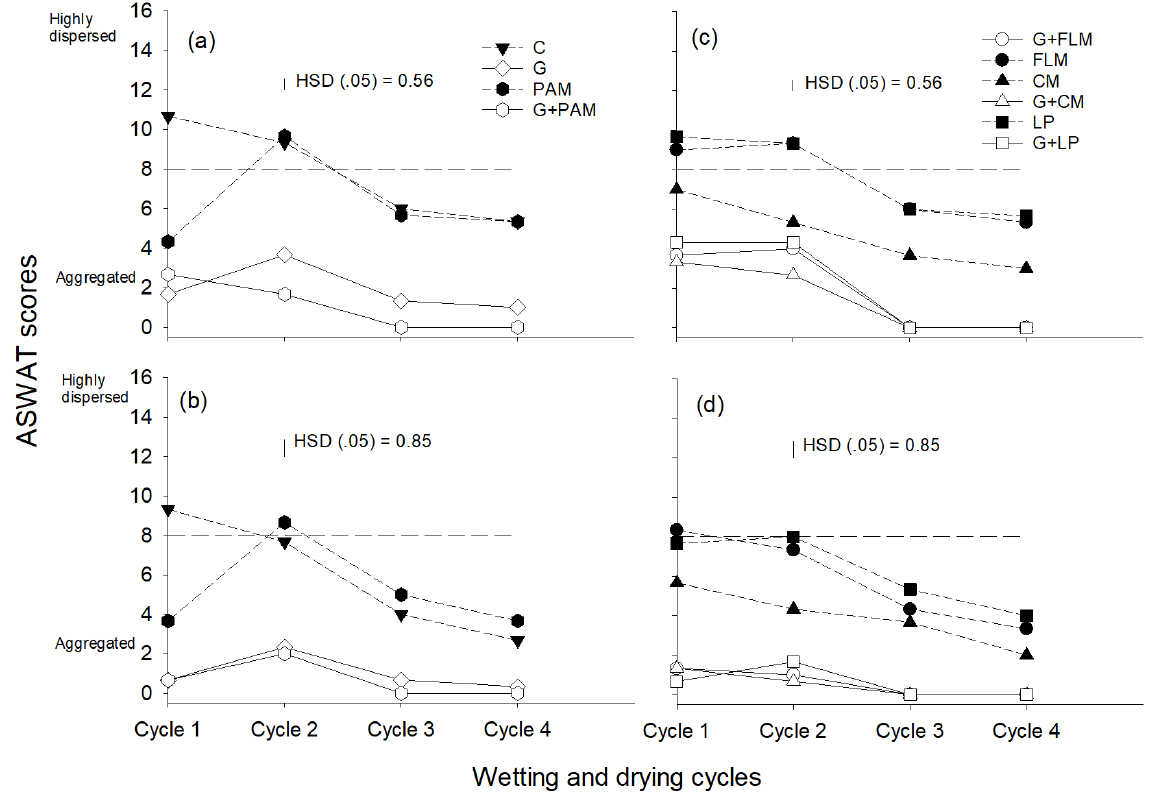
Figure 3. The ASWAT scores of soils after the addition of amendments during four wetting and drying (WD) cycles, Soil 1 (a, c) and Soil 2 (b, d) . The amendments are C: control, G: gypsum, PAM: anionic polyacrylamide, G + PAM: gypsum + anionic polyacrylamide, FLM: feedlot manure, G + FLM: gypsum + feedlot manure, CM: chicken manure, G + CM: gypsum + chicken manure, LP: lucerne pellets, and G + LP: gypsum + lucerne pellets. Vertical bars represent Tukey’s honest significant difference (HSD) values at p = 0 . 05 for pairwise comparisons among